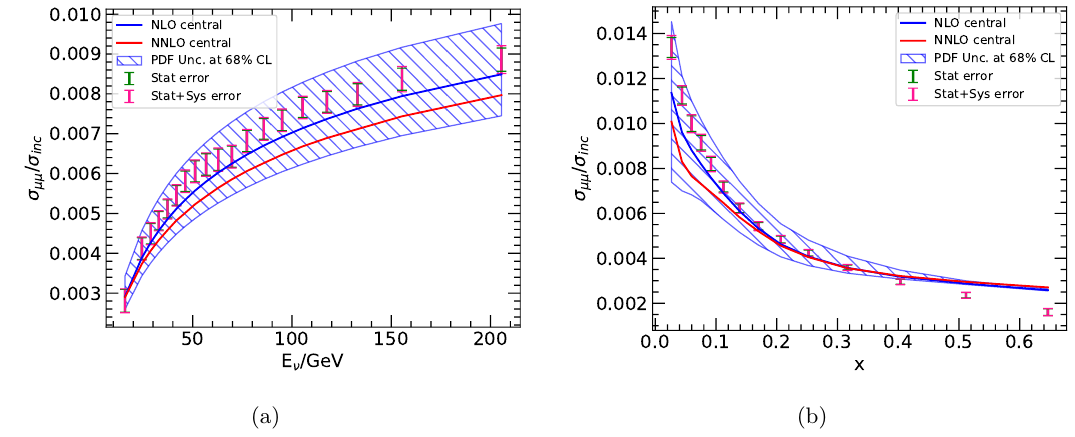
Figure 15 . NLO (blue line) and NNLO (red line) predictions for ratios of dimuon to CCDIS inclusive differential cross-sections with respect to neutrino energy (panel a) and Bjorken x (panel. b). The blue hatched areas represent the Hessian PDF uncertainties of the NLO predictions at 68% CL. NOMAD data are also shown with statistical uncertainties and the combination of both statistical and systematic uncertainties.